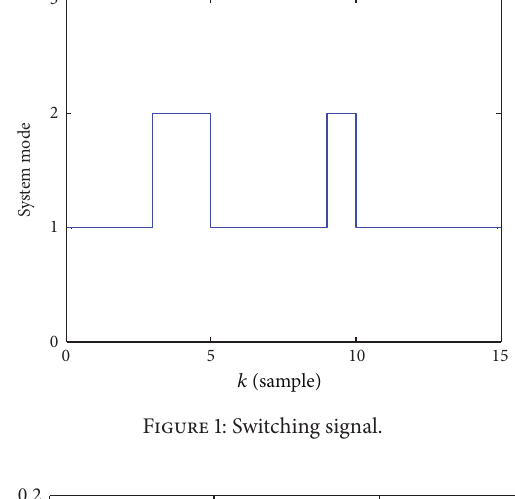
Figure 1: Switching signal.